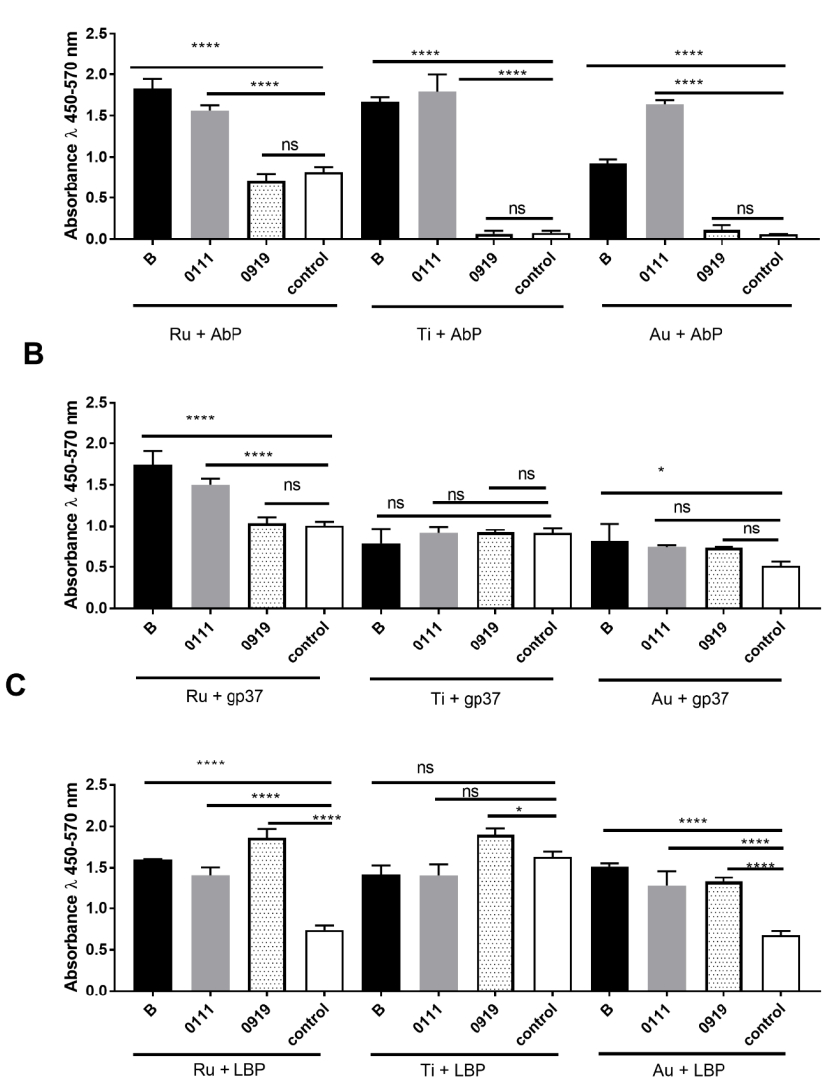
Figure 6. The reactivity of ( A ) polyclonal anti- Escherichia coli antibody, ( B ) adhesin gp37, ( C ) lipopolysaccharide binding protein (LBP) immobilized on different metal surface Ru, Ti, or Au by glutaraldehyde ( A ) or NiCl 2 ( B , C ) with Escherichia coli strains: 056, K12, 0111, B, and Lactobacillus rhamnosus LOCK 0919 (0919). Pooled results from three independent experiments are shown. *, P < 0.05; ****, P < 0.0001; ns-non-significant.